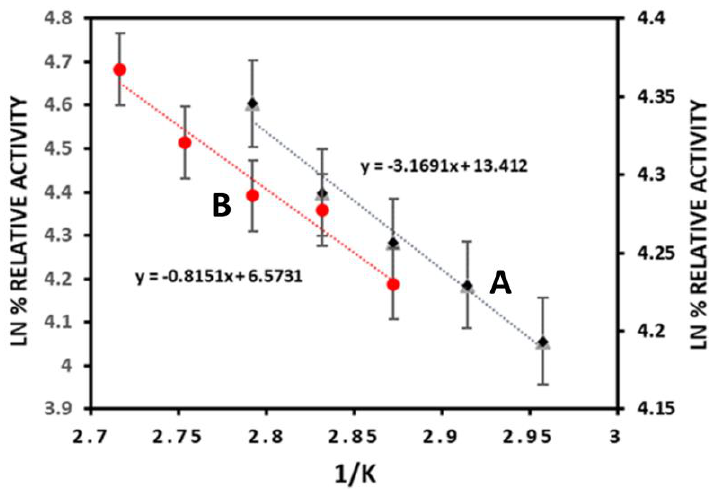
Figure 4. Arrhenius plots for free and immobilized Man/Cel5B. (A) Free Man/Cel5B (B) Immobilized Man/Cel5B. Table 1. Thermodynamic parameters of immobilized and free enzyme for LBG degradation.